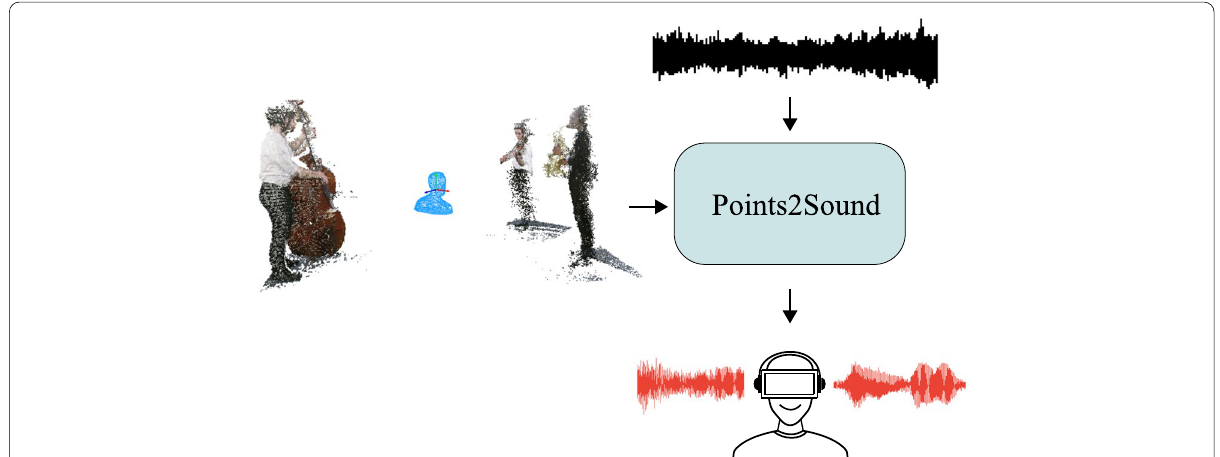
Fig. 1 Points2Sound is a deep learning model capable of generating a binaural version from mono audio that matches a 3D point cloud scene